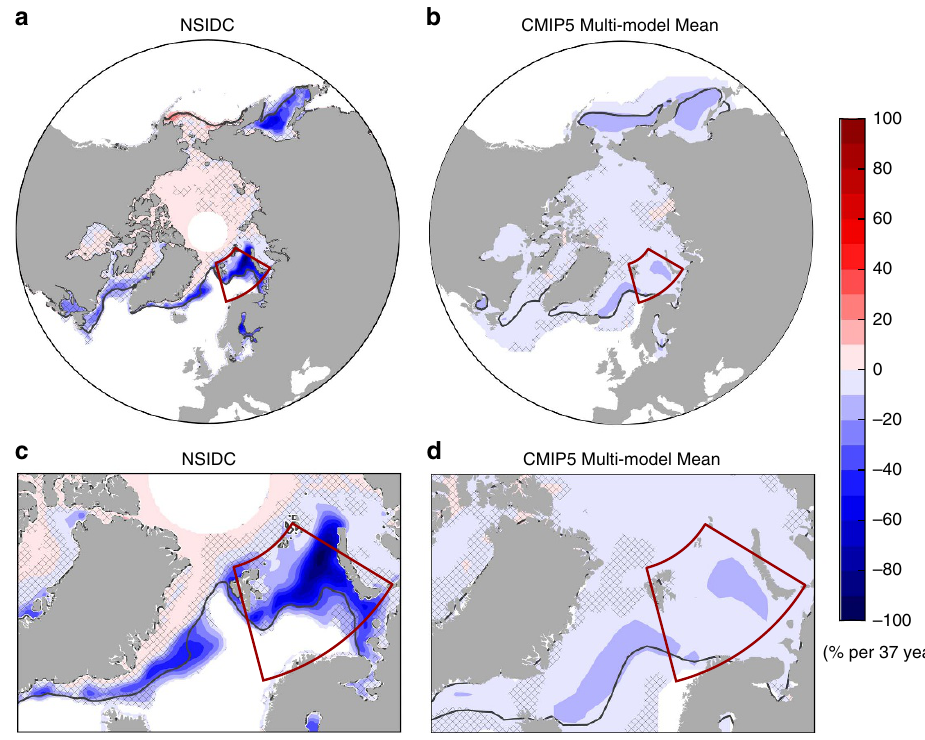
Figure 2 | Spatial pattern of observed and CMIP5 multi-model-simulated March SIC trend over 1979–2015. ( a , c ) Observations (NSIDC), ( b , d ) CMIP5 multi-model ensemble mean. The lower panels zoom in over the Barents Sea. Black lines mark the climatological March sea ice edge, and the red box outlines the Barents Sea. SIC from individual CMIP5 models are regridded onto a common polar-stereographic grid so that a multi-model ensemble mean is applicable. Grid points with a mean SIC less than 1% are masked white. In a , c , grid points poleward of 85 (cid:2) N are also masked due to missing data. The unhatched regions in all panels have statistically significant trends at 95% confidence